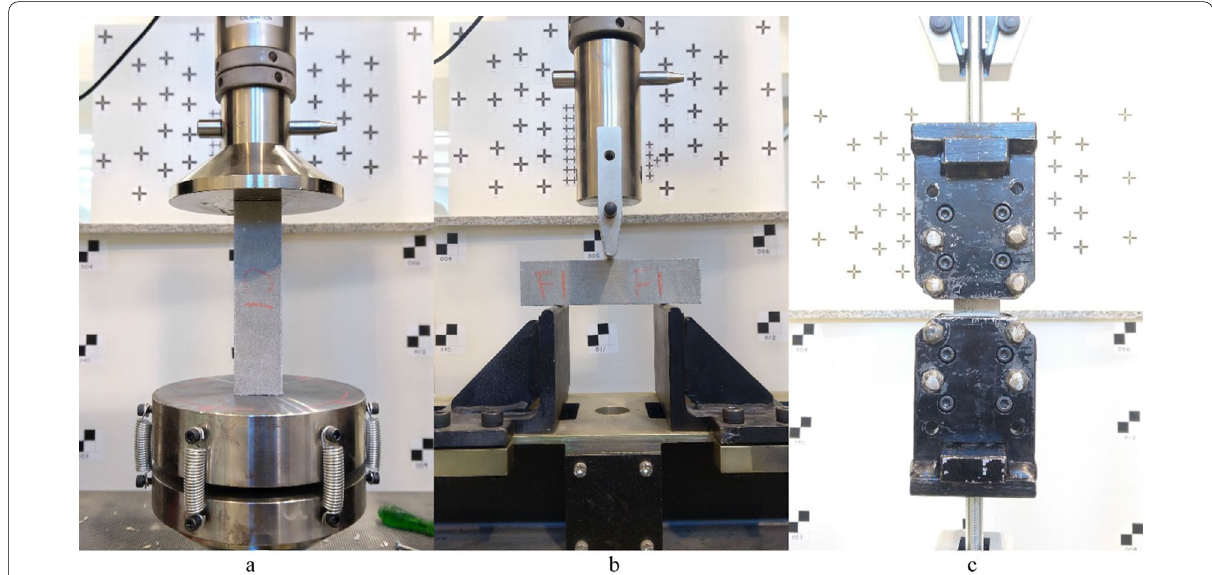
Fig. 2 Methods of test for mortar: a compressive test; b flexural test, c tensile